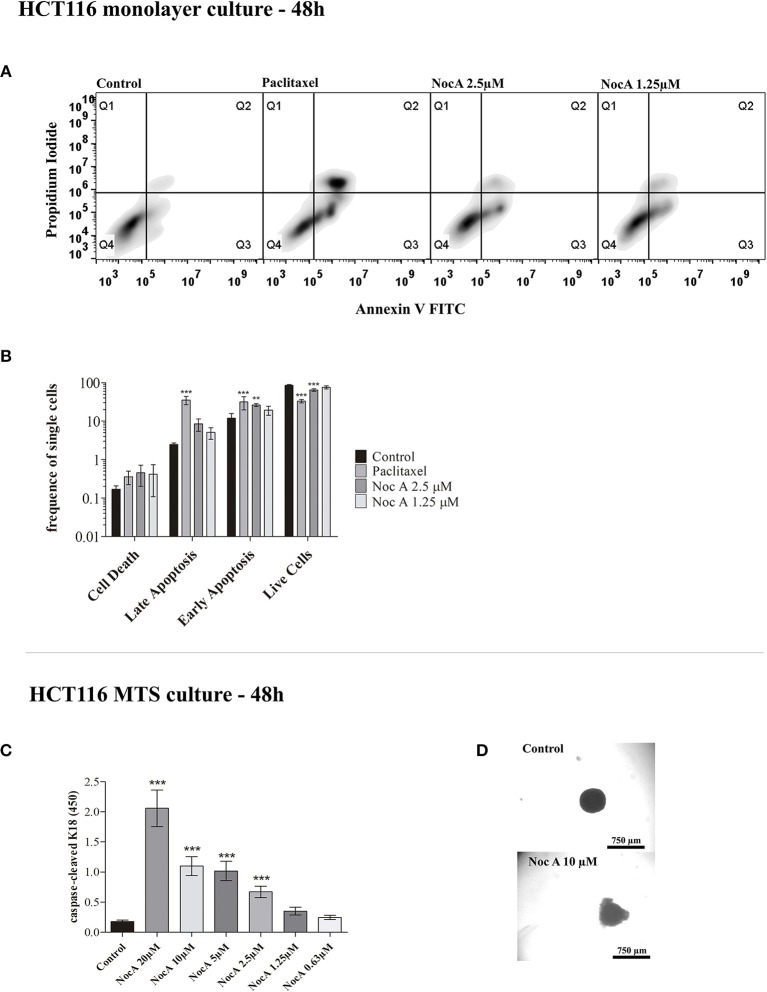
Analysis of apoptosis on monolayer culture and multicellular spheroids (MTS). (A) Apoptosis analysis of monolayer culture HCT116 cells using flow cytometry with Annexin V and Propidium iodide staining. (B) Quantifications of flow cytometry results. Apoptosis is observed after 48 h at 2.5 μM. ***p < 0.001; **p < 0.01. Ten thousand cells per gated replicate were counted, n = 3. (C) M30 CytoDeathTM ELISA absorbance readings on HCT116 MTS exposed to NocA up to 20 μM. High absorbance values represent higher levels of caspase-cleaved K18. Two independent assays were performed, n = 3. (D) Bright field images of MTS after 48 h of exposure, being the top image a control and the bottom image an MTS exposed to Noc A at 10 μM; ***p < 0.001.